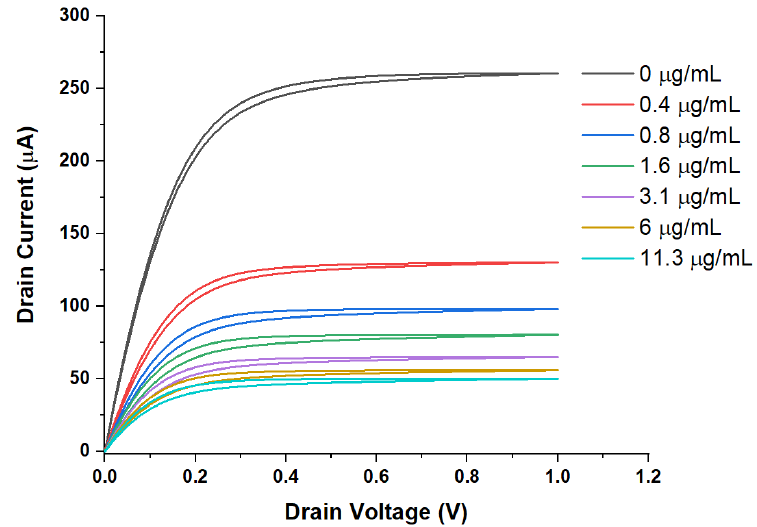
Figure 2. Output characteristics under increasing spike protein concentration, c. Note, all outputs are taken at V G = 0.3 V, and only c varies.